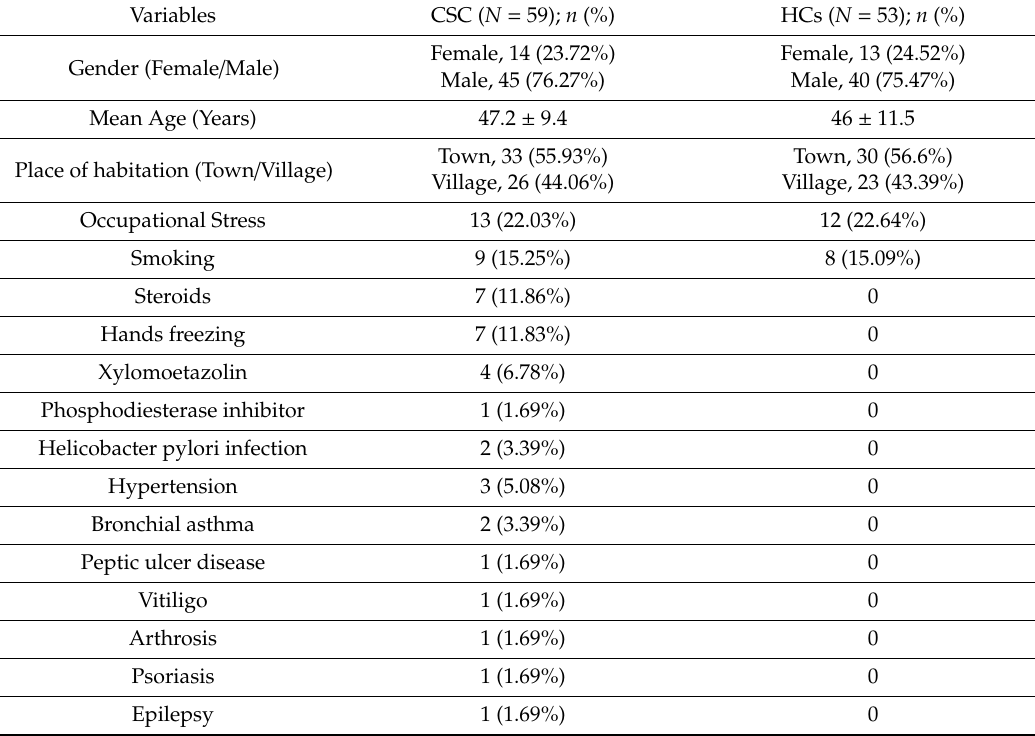
Table 1. Demographics data of central serous chorioretinopathy (CSC) patients and healthy controls